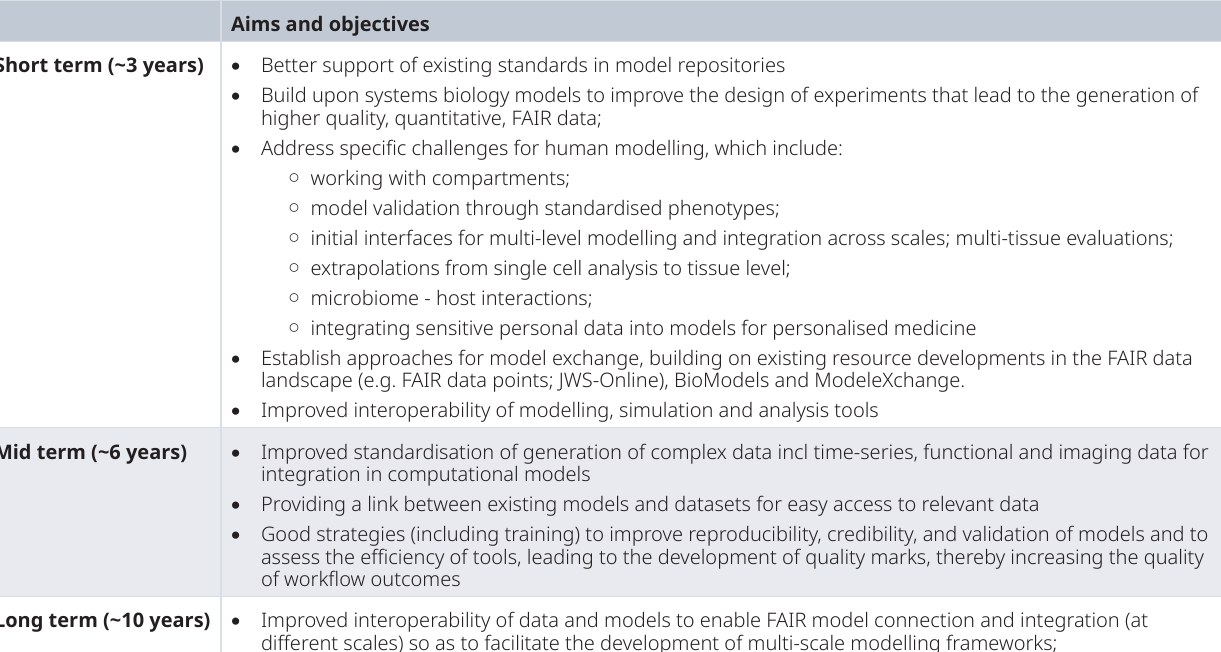
Table 4. Breakdown of short, mid and long term objectives for the Standardisation & Interoperability theme. Aims and